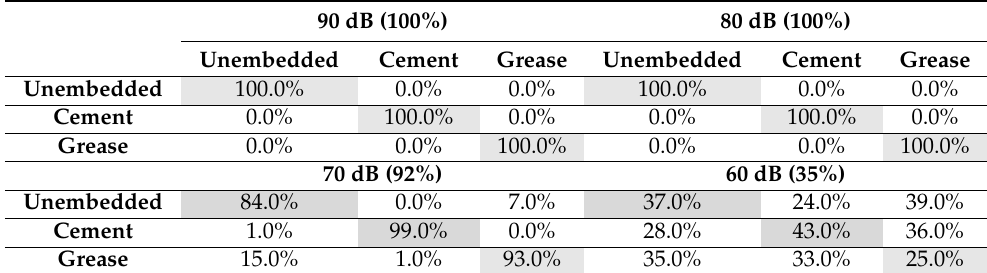
Figure 13. Results of CNN at various noise levels. Table 5. Confusion matrices in varying embedding conditions.